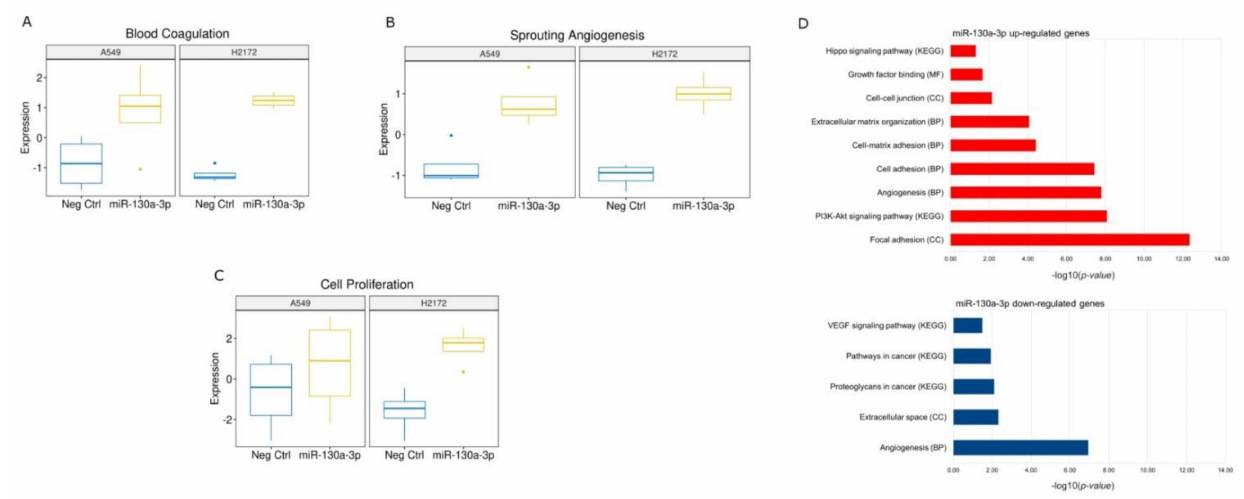
Figure 10. ( A – C ) Box plots of the enriched pathways predicted by gene expression values on nSolver software analysis of the specific pathway up-regulated in the transfected cells with miR-130a-3p. ( D ) Bar charts report the most relevant functional annotations obtained by DAVID Bioinformatics tool using the overexpressed (red bar) and down-modulated (blue bar) genes in miR-130a-3p transfected cells versus NC. The lists were sorted by log-false discovery rate (logFDR) values. BP: Biological Process; MF: Molecular Function; CC: Cellular